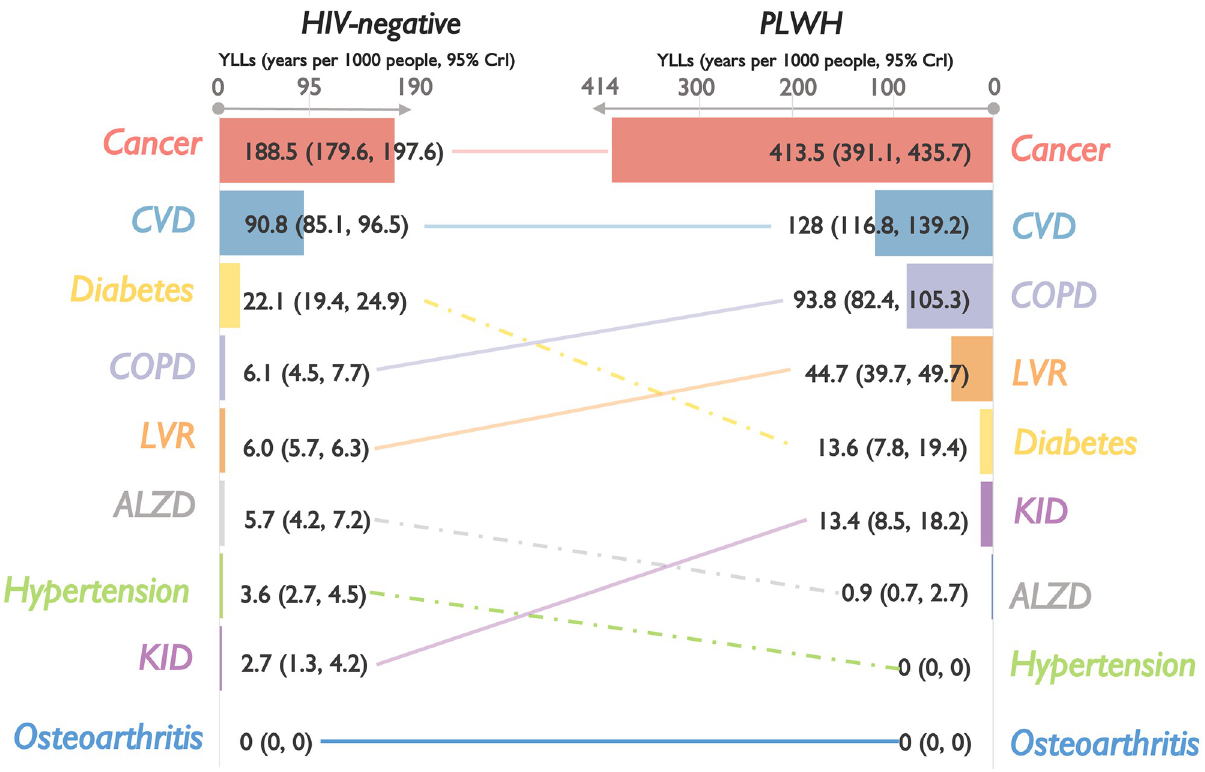
Fig 1. Cumulative DALYs (2008–2012) per 1000 people, with 95% credible intervals, associated with nine selected chronic comorbidities, ranked from highest to lowest, by HIV status in British Columbia, Canada. Note: PLWH: people living with HIV; DALYs: disability-adjusted life years; 95% CrI: 95% credible intervals; ALZD: Alzheimer’s and/or non-HIV-related dementia (denominator included only individuals aged 40 years and older); Cancers: non-AIDS-defining cancer; COPD: chronic obstructive pulmonary disease (denominator included only individuals aged 35 years and older); CVD: cardiovascular diseases; KID: kidney diseases; LVR: liver diseases. Horizontal scales differ between PLWH and HIV-negative controls for illustration